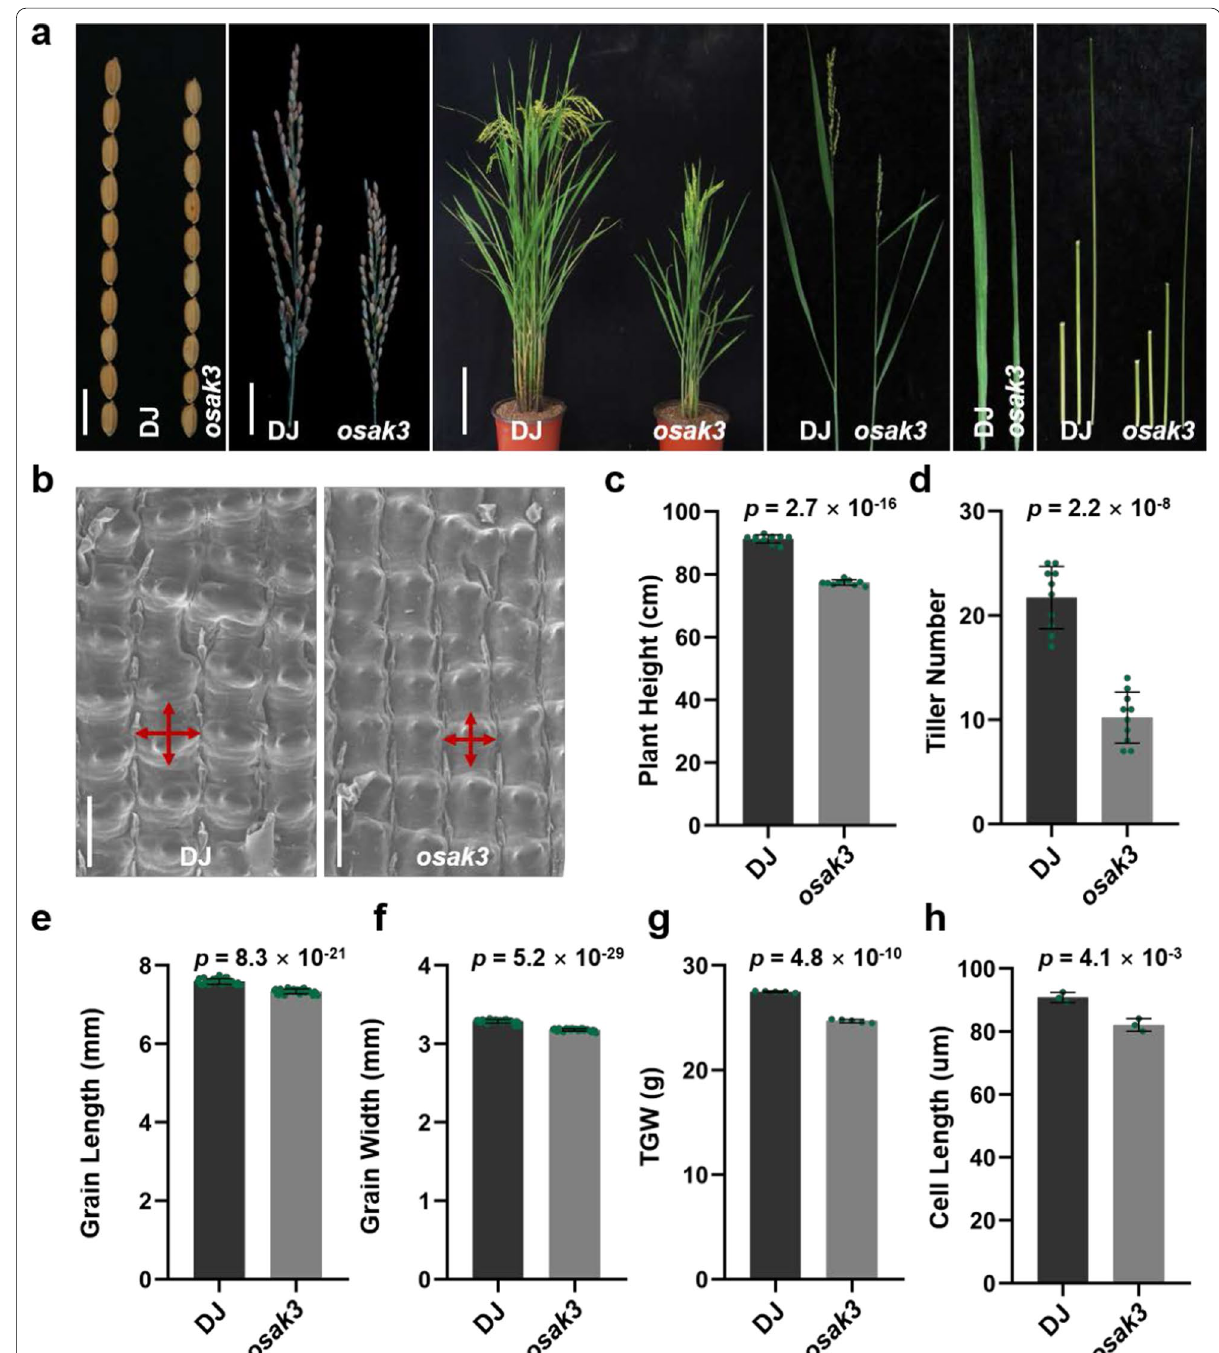
Fig. 3 Morphological characteristics of osak3 mutant. a Plant phenotype of DJ and osak3 at the mature stage. From left to right are grain size (scale bar, 1 cm), panicles (scale bar, 3 cm), plant profile (scale bar, 20 cm), morphology of main axis, flag leaf, internodes. b Scanning electron microscopic observation of the spikelet glume cells of DJ and osak3 . Scale bars, 100 μm. c, d Statistical data of plant height ( c ) and tiller number ( d ). Data are means SD ( n 10). P value compared with the wild type by student’s t test. e, f Statistical data of grain length ( e ) and grain width ( f ). Data are ± = means SD ( n 30). P value compared with the wild type by student’s t test. g Statistical data of 1000-grain weight. Data are means ± = value compared with the wild type by student’s t test. h Statistical data of spikelet glume cell length. Data are means with the wild type by student’s t